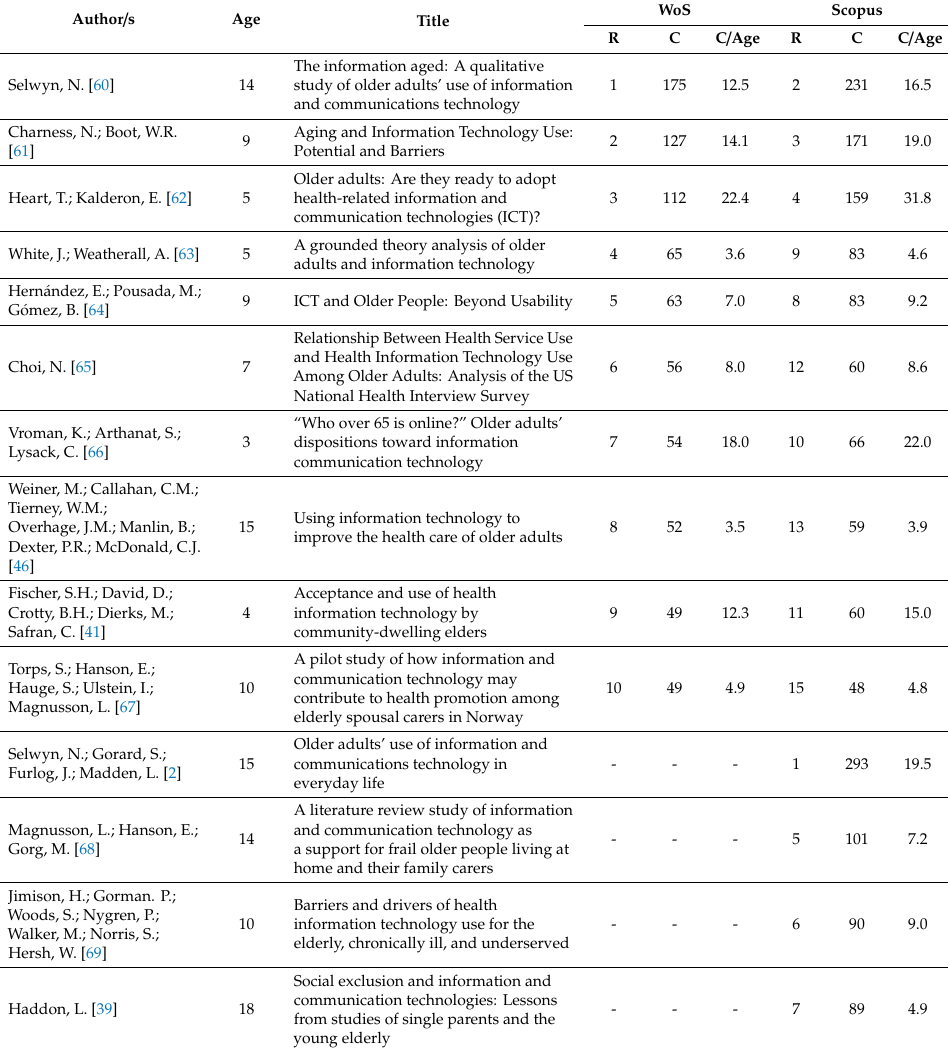
Table 2. Ranking of the most cited